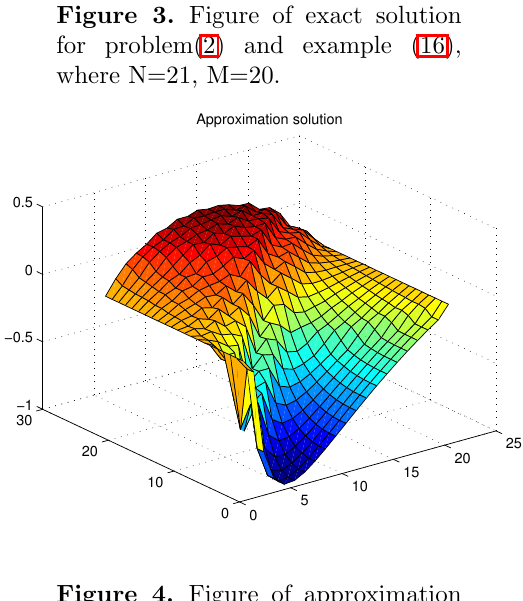
Figure 4. Figure of approximation solution for problem(2) and example (16), where N=21,